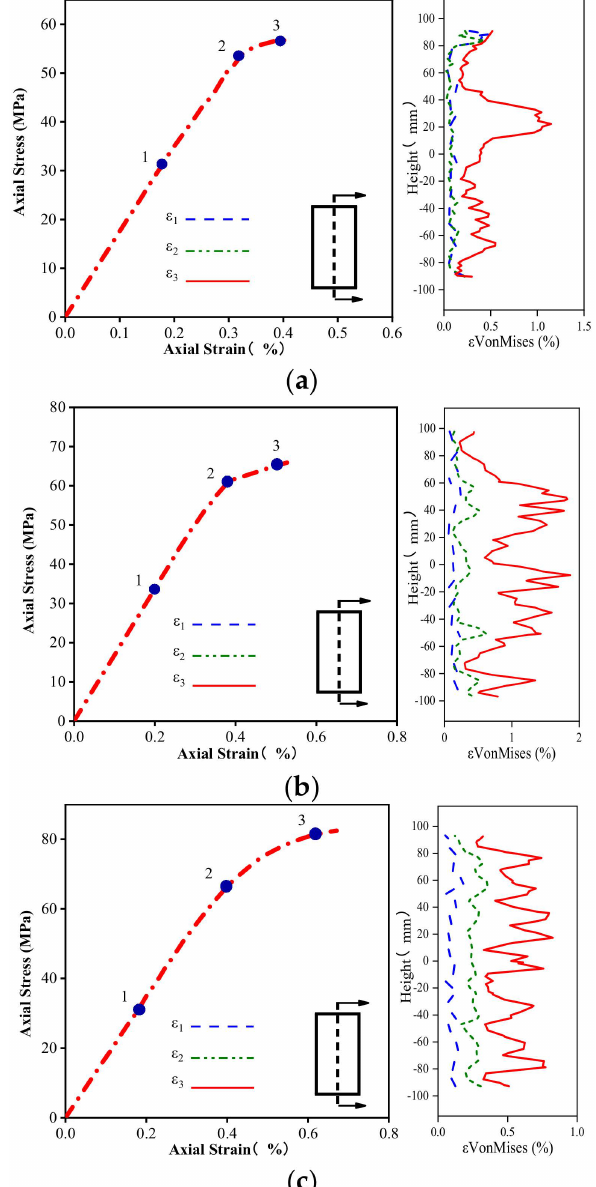
Figure 12. Comparing the Von Mises strain development of ( a ) M1, ( b ) M2, and ( c )